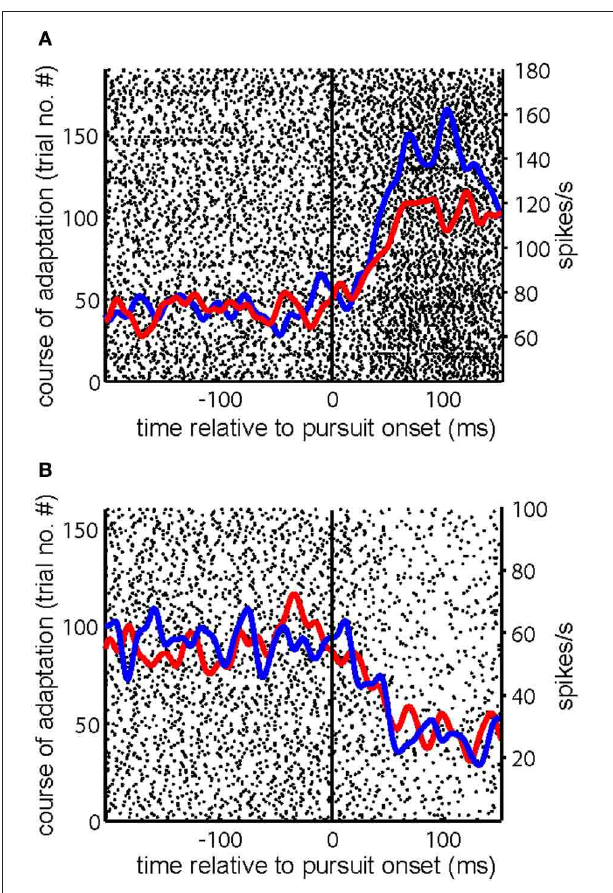
FIGURE 3 | Examples of PC SS during gain decrease SPA. (A,B) Show the raster plot of a PC SS during the course of gain-decrease SPA with superimposed spike density functions for the first (blue) and the last (red) quarter of the trials. The solid vertical line indicates SPEM onset. The course of adaptation is from bottom to